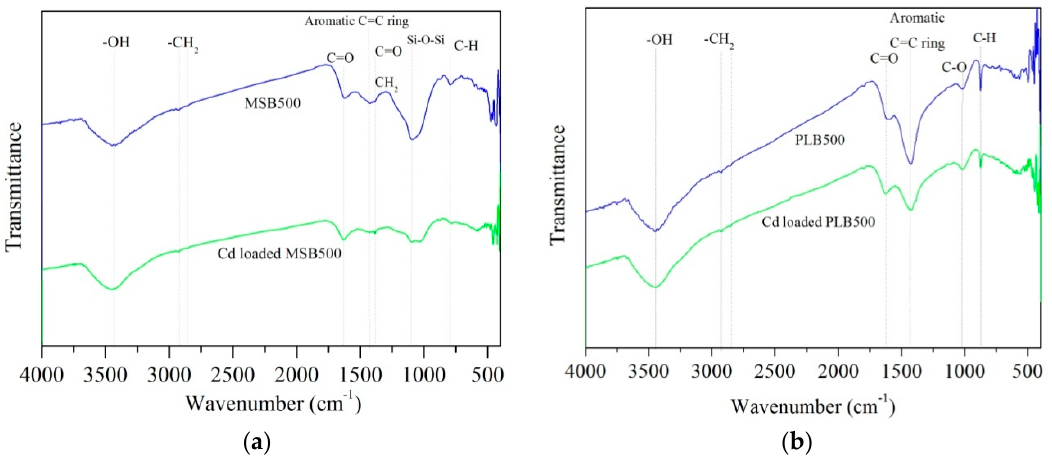
Figure 14. FTIR spectra of MSB500 ( a ) and PLB500 ( b ) before and after Cd adsorption.